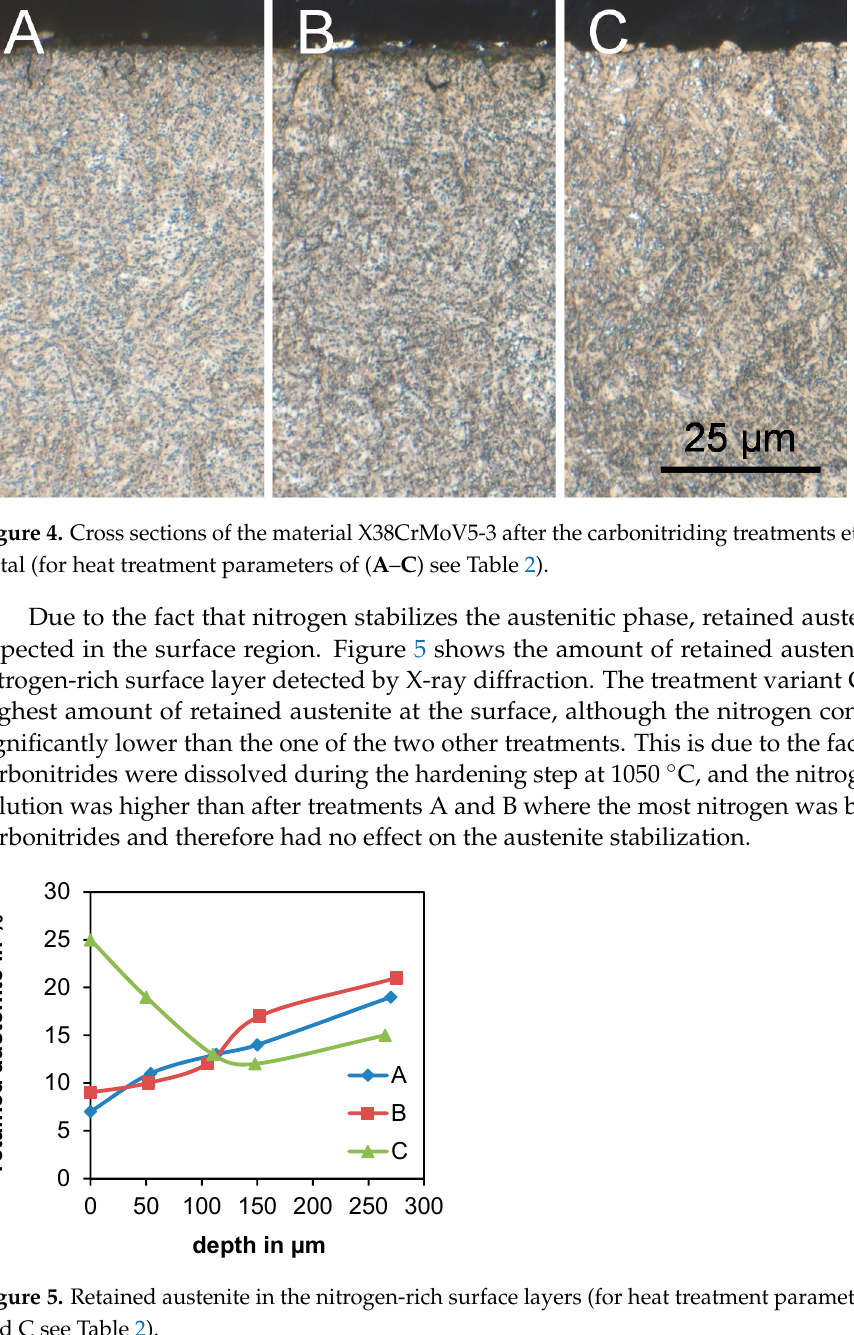
Figure 3. Unetched cross sections of the material X38CrMoV5-3 after the carbonitriding treatments (for heat treatment parameters of ( A – C ) see Table 2).